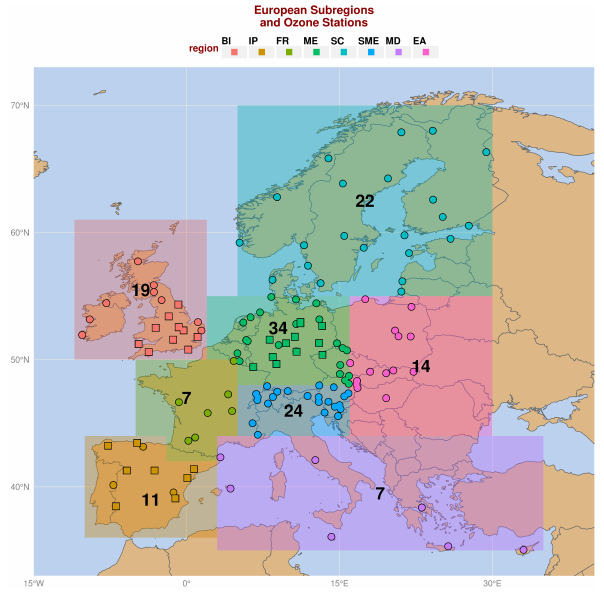
Figure 1. The European subregions that were used in the analysis and the corresponding EMEP and AIRBASE stations. The num- bers denote the number of stations taken into consideration for ev- ery subregion. The subregions are: Britain and Ireland (BI), France (FR), Iberian Peninsula (IP), Eastern Europe (EA), middle Europe (ME), Mediterranean (MD), south-middle Europe (SME) and Scan- dinavia